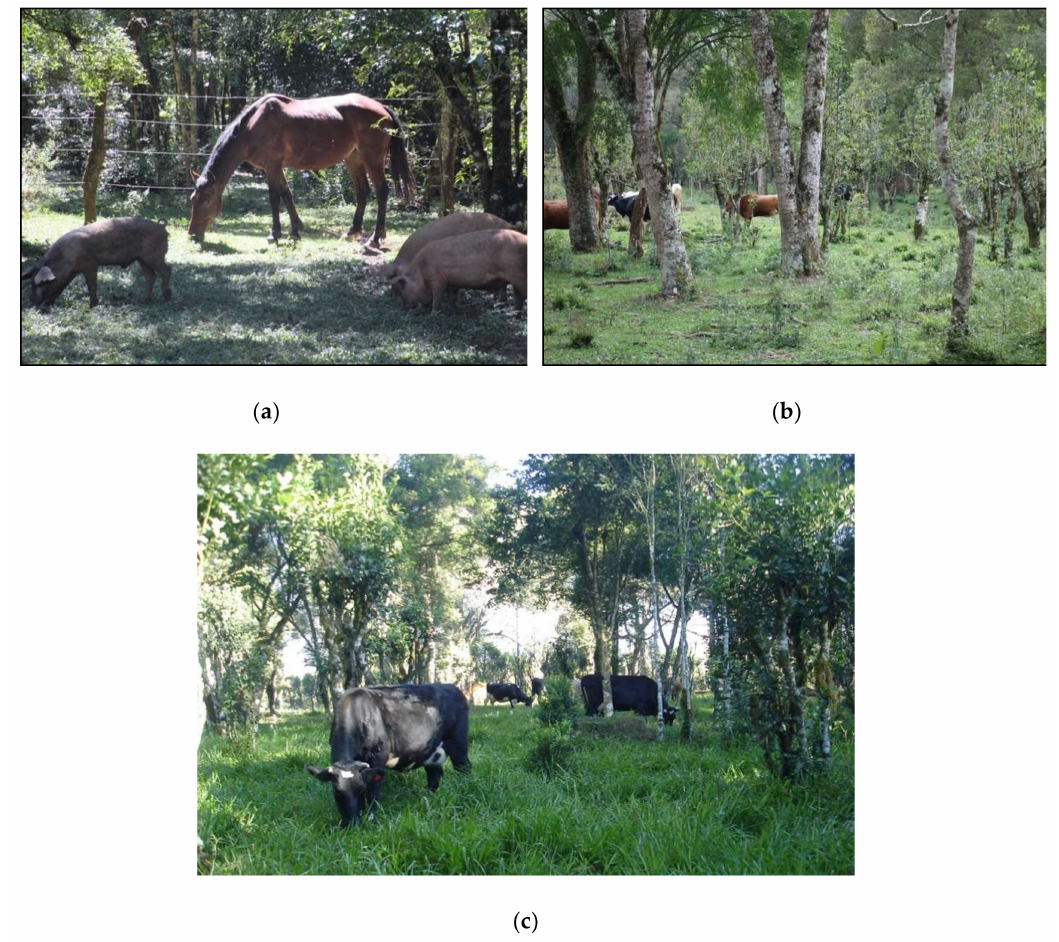
Figure 3. Traditional silvopastoral systems: ( a ) animal husbandry within forest stands in a faxinal ; ( b ) ca í va with low productivity pasture and senile erva-mate trees (small trees in the background, to the right); ( c ) view of a ca í va with improved